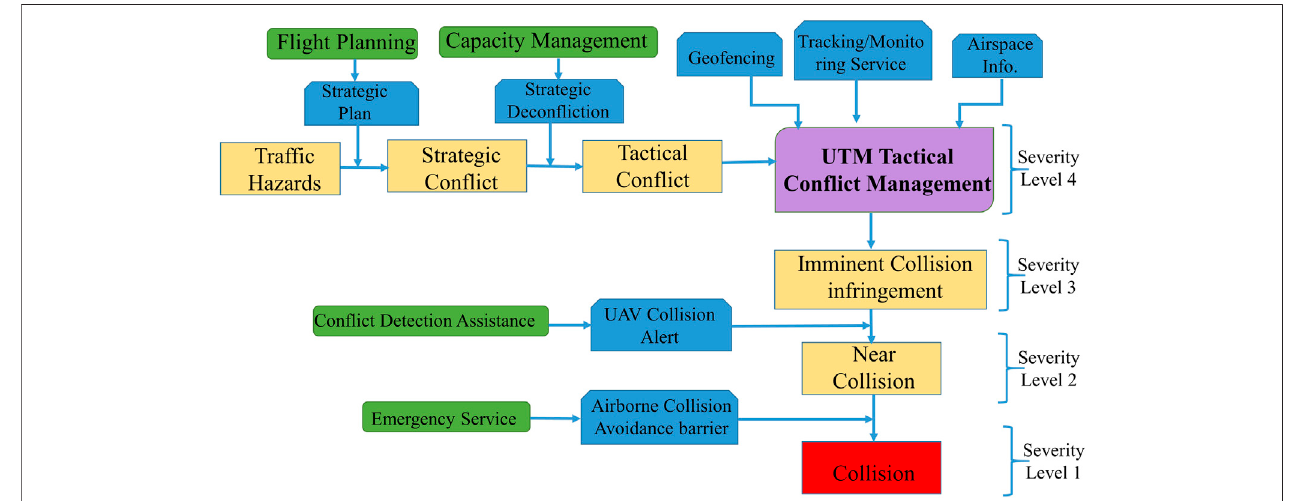
FIGURE 10 | Simpli fi ed accident-incident model for advance